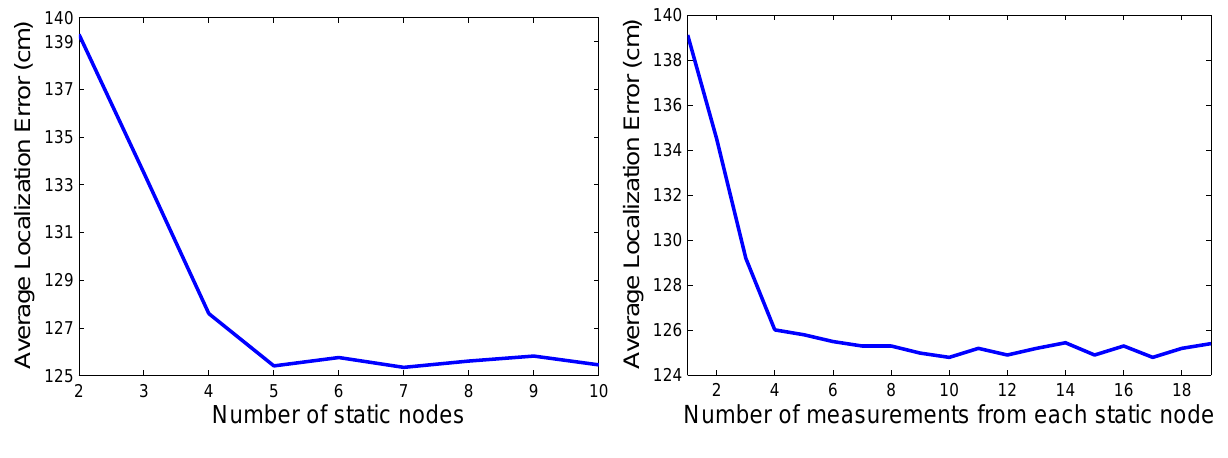
Figure 10. ( Left ) Average localization error VERSUS number of static nodes taken into account in the training of the RSSI-range models. Each static node contributed with 200 measurements to the training set; ( Right ) Average localization error VERSUS number of measurements from each static node taken into account in the training of the RSSI-range model. The training set contains measurements from five different static